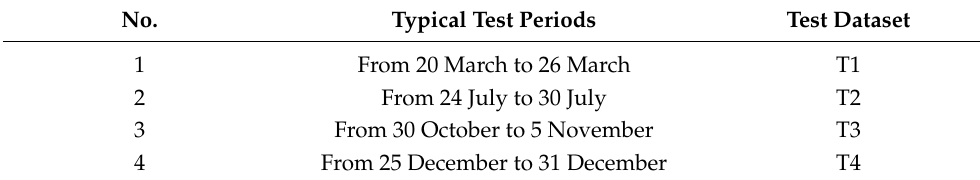
Table 6. Typical test periods.